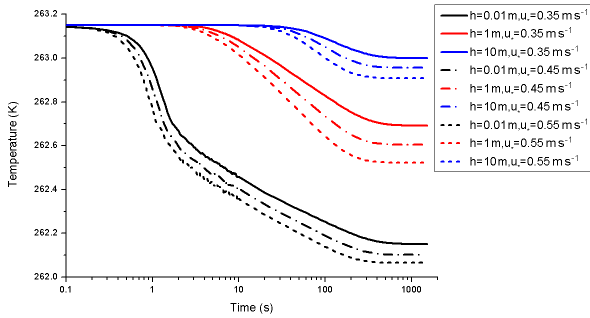
Figure 7. Temporal evolution of temperature for various